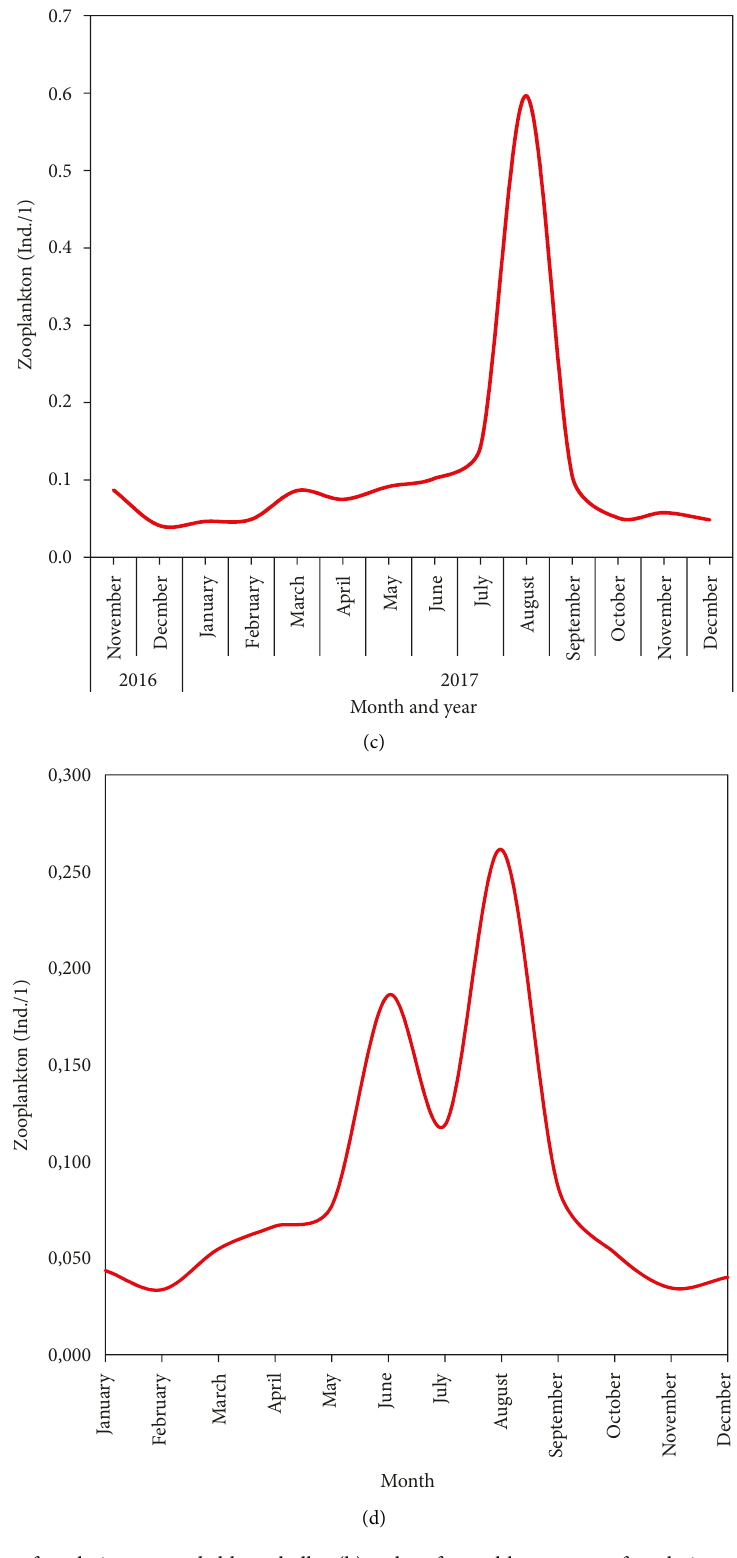
Figure 1: (a) Time series plot of total nitrogen and chlorophyll a; (b) a plot of monthly averages of total nitrogen and chlorophyll a; (c) time series plot of zooplankton; (d) a plot of monthly averages of